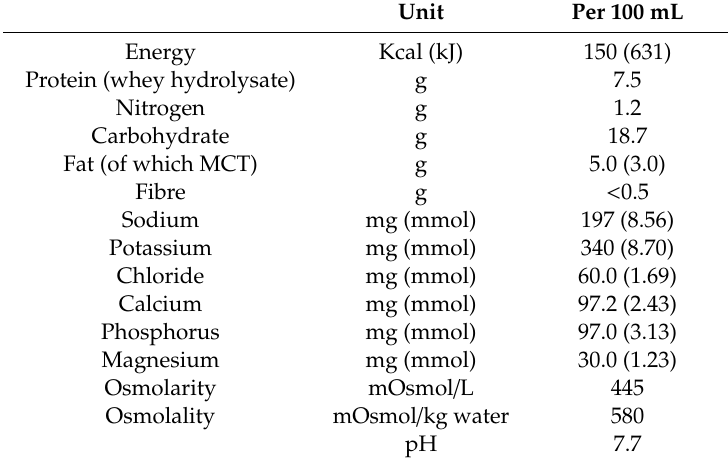
Table 1. Nutritional composition of the HEHP (high-energy, high-protein) intervention feed